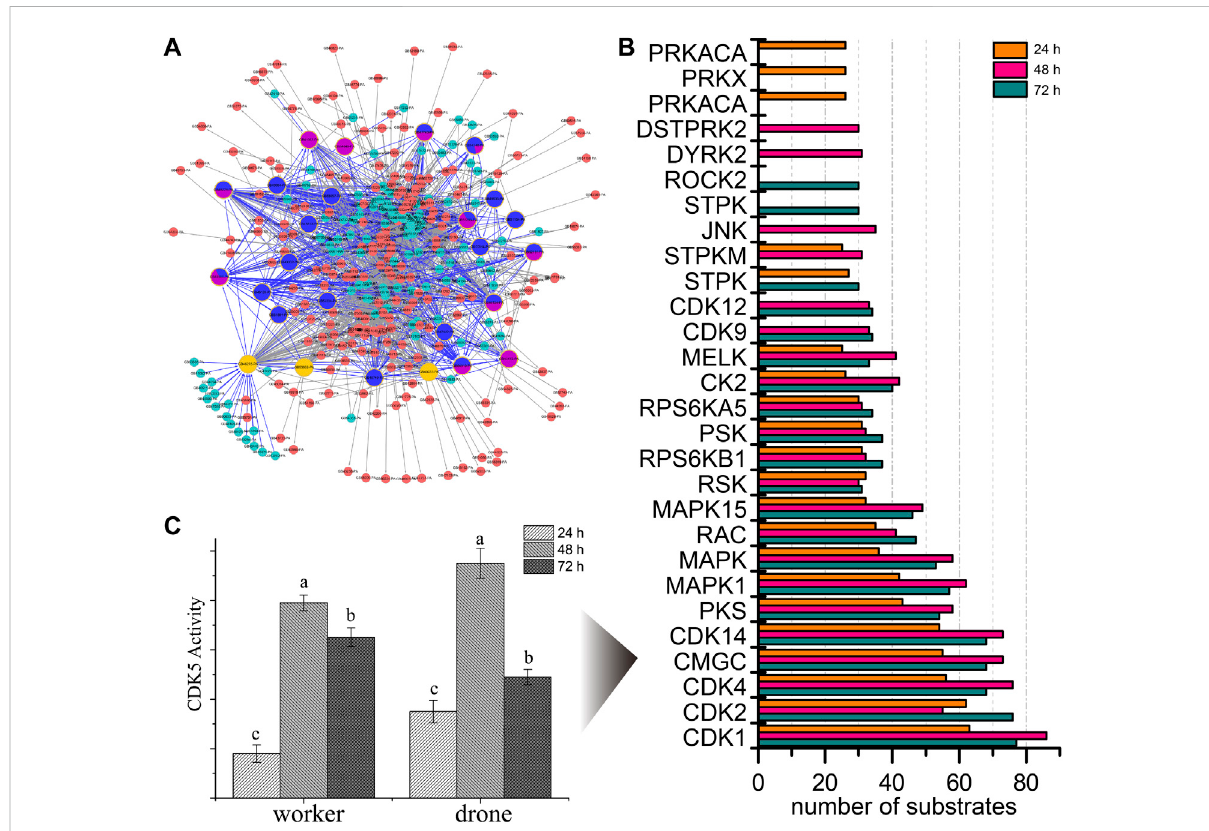
The predicted site-speci fi c kinase-substrate relations (ssKSRs) in worker embryos. GPS 2.1 software package (Group-based Prediction System, https://igps.biocuckoo.org) was used to predict potential ssKSRs systematically. Protein-protein interactions of A. mellifera retrieved from the database of STRING v10 (https://www.string-db.org/) were used to reduce possible false positive hits of the predicted ssKSRs. (A) The network was constructed from the identi fi ed phosphoproteins in 24 h worker embryo. The highlighted proteins are kinases identi fi ed in this study. (B) The kinase activity analyses for the phosphoproteome of the worker. The top 20 high-activity kinases over the three stages of development are compared. (C) TheenzymaticactivityofCDK5indifferentphases duringtheembryogenesisofworkerand drone.Errorbar isthestandarddeviation. “ a ” is signi fi cantly higher than “ b ” and “ c ” , “ b ” is signi fi cantly higher than “ c ”